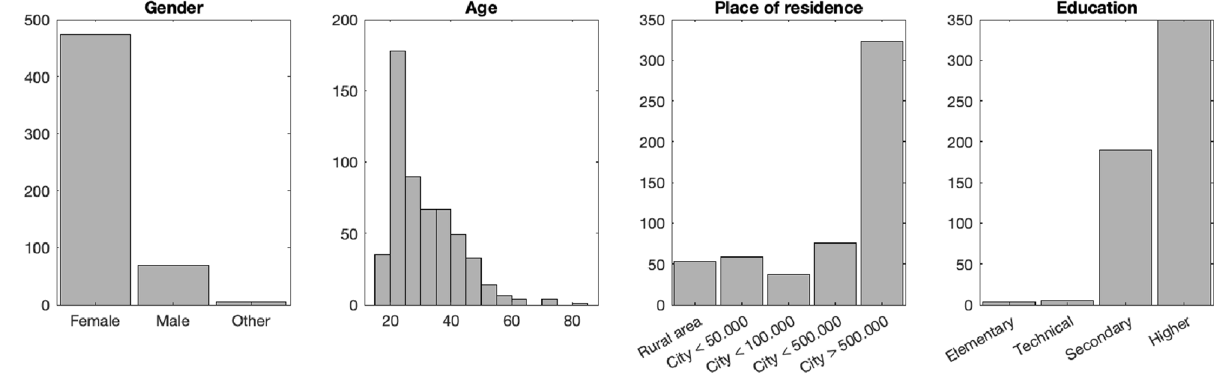
Figure 2. Demographic information about the study sample (N = 548) included in the final